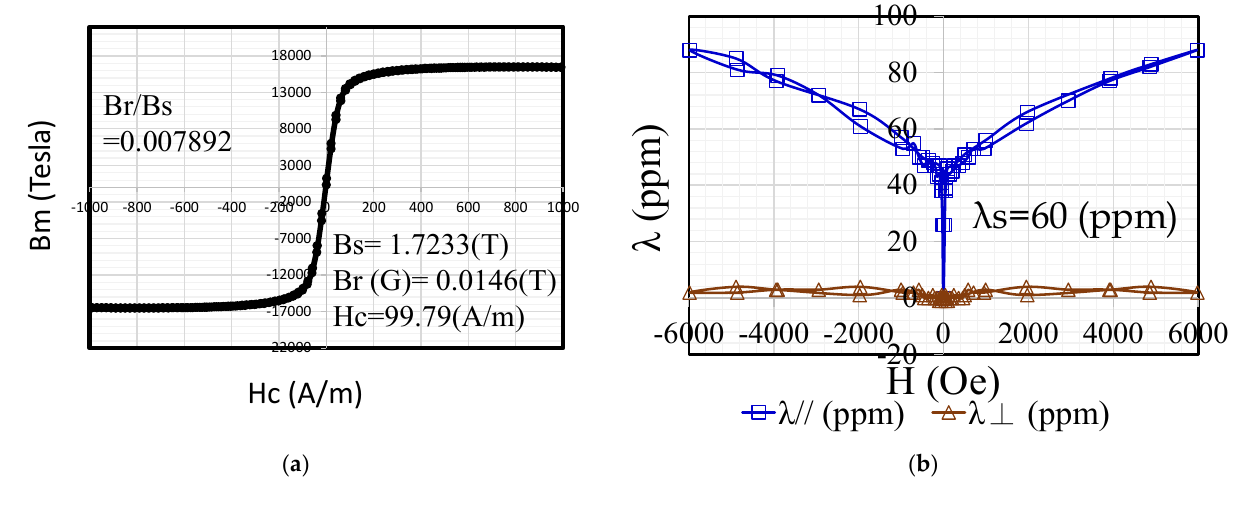
Figure 3. Magnetostriction measurement of amorphous SA1 material: (a) VSM and (b) magneto- striction.